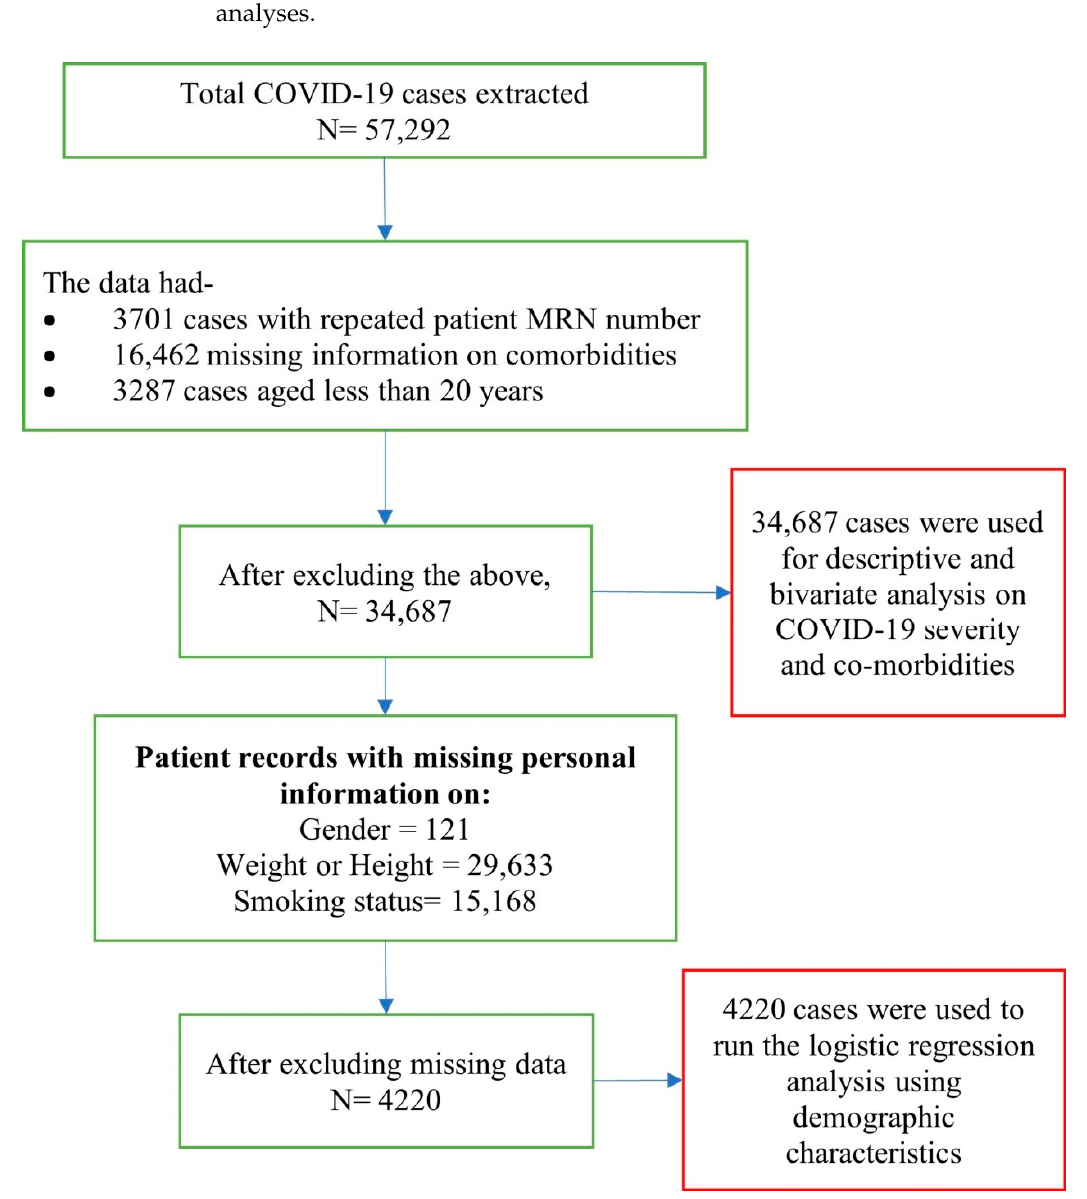
Figure 1. Description and breakdown of patient